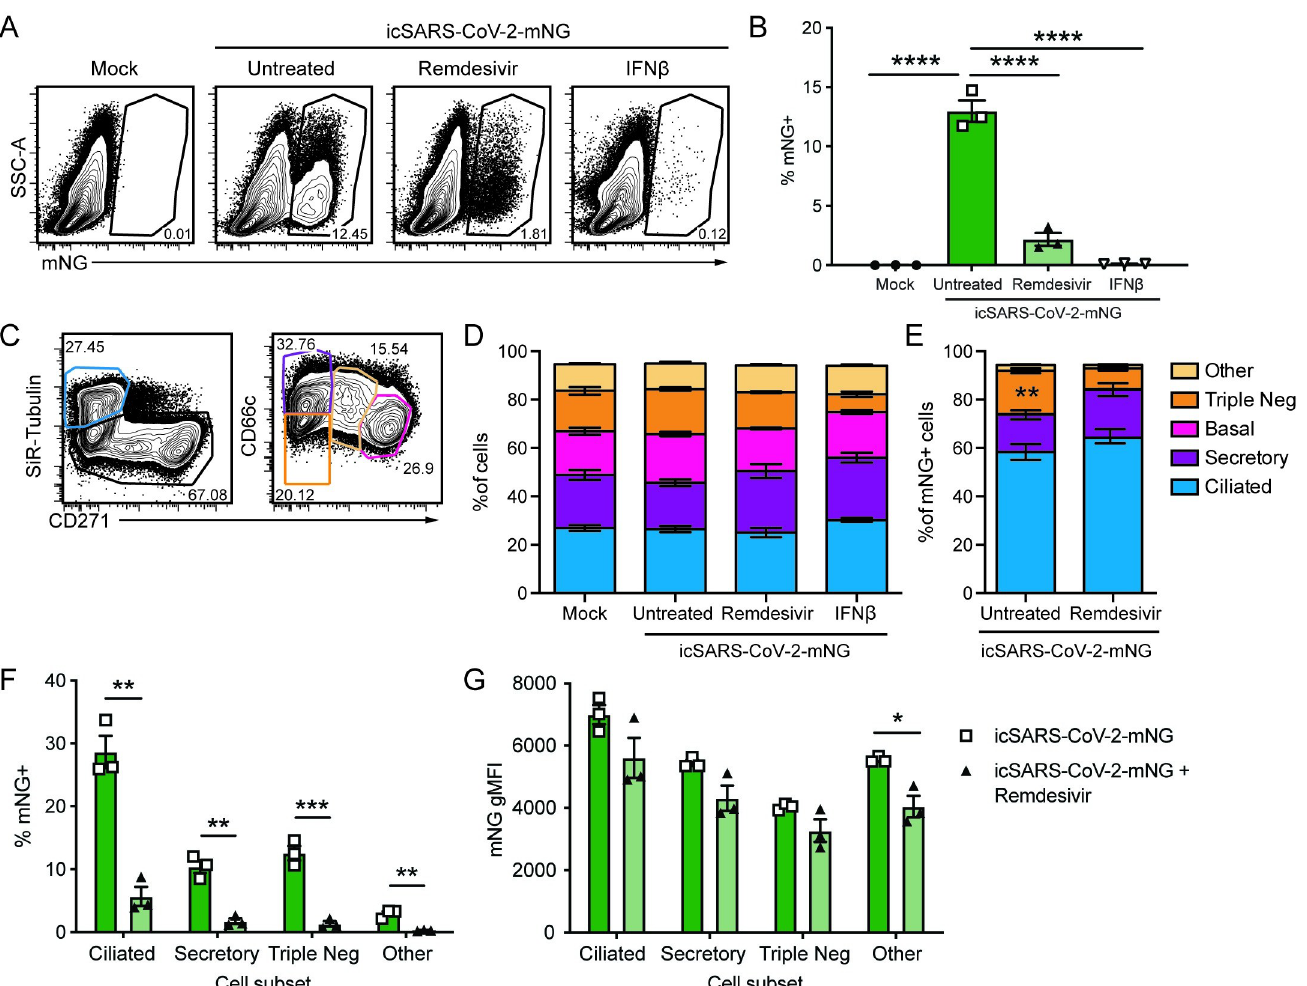
Fig 1. SARS-CoV-2 infects multiple cell types and infection is controlled by remdesivir in primary nHTBE cells. nHTBE cells differentiated at air-liquid interface were untreated or treated with IFN- β or remdesivir prior to infection with icSARS-CoV-2-mNG at a MOI of 2.5. Cells were analyzed 48 hpi by flow cytometry. (A) Representative plots of live cells (B) Frequency of infected cells (mNG + ). (C) Representative plots of cell subset gating. Ciliated (SiR-Tubulin + CD271 - ), secretory (SiR-Tubulin - CD271 - CD66c + ), basal (SiR-Tubulin - CD271 + CD66c - ), Triple negative (SiR-Tubulin - CD271 - CD66c - ) and other cells (SiR-Tubulin - CD217 int CD66c int ) (D) Frequency of cell subsets from live cells. (E) Frequency of cell subsets of infected cells (mNG + ). (F) Total frequency of mNG + infected cell types. (G) mNG gMFI within each cell subset. The data (B, D-F) are 3 biological replicates per group +/-SEM, 1 of 2 independent experiments.